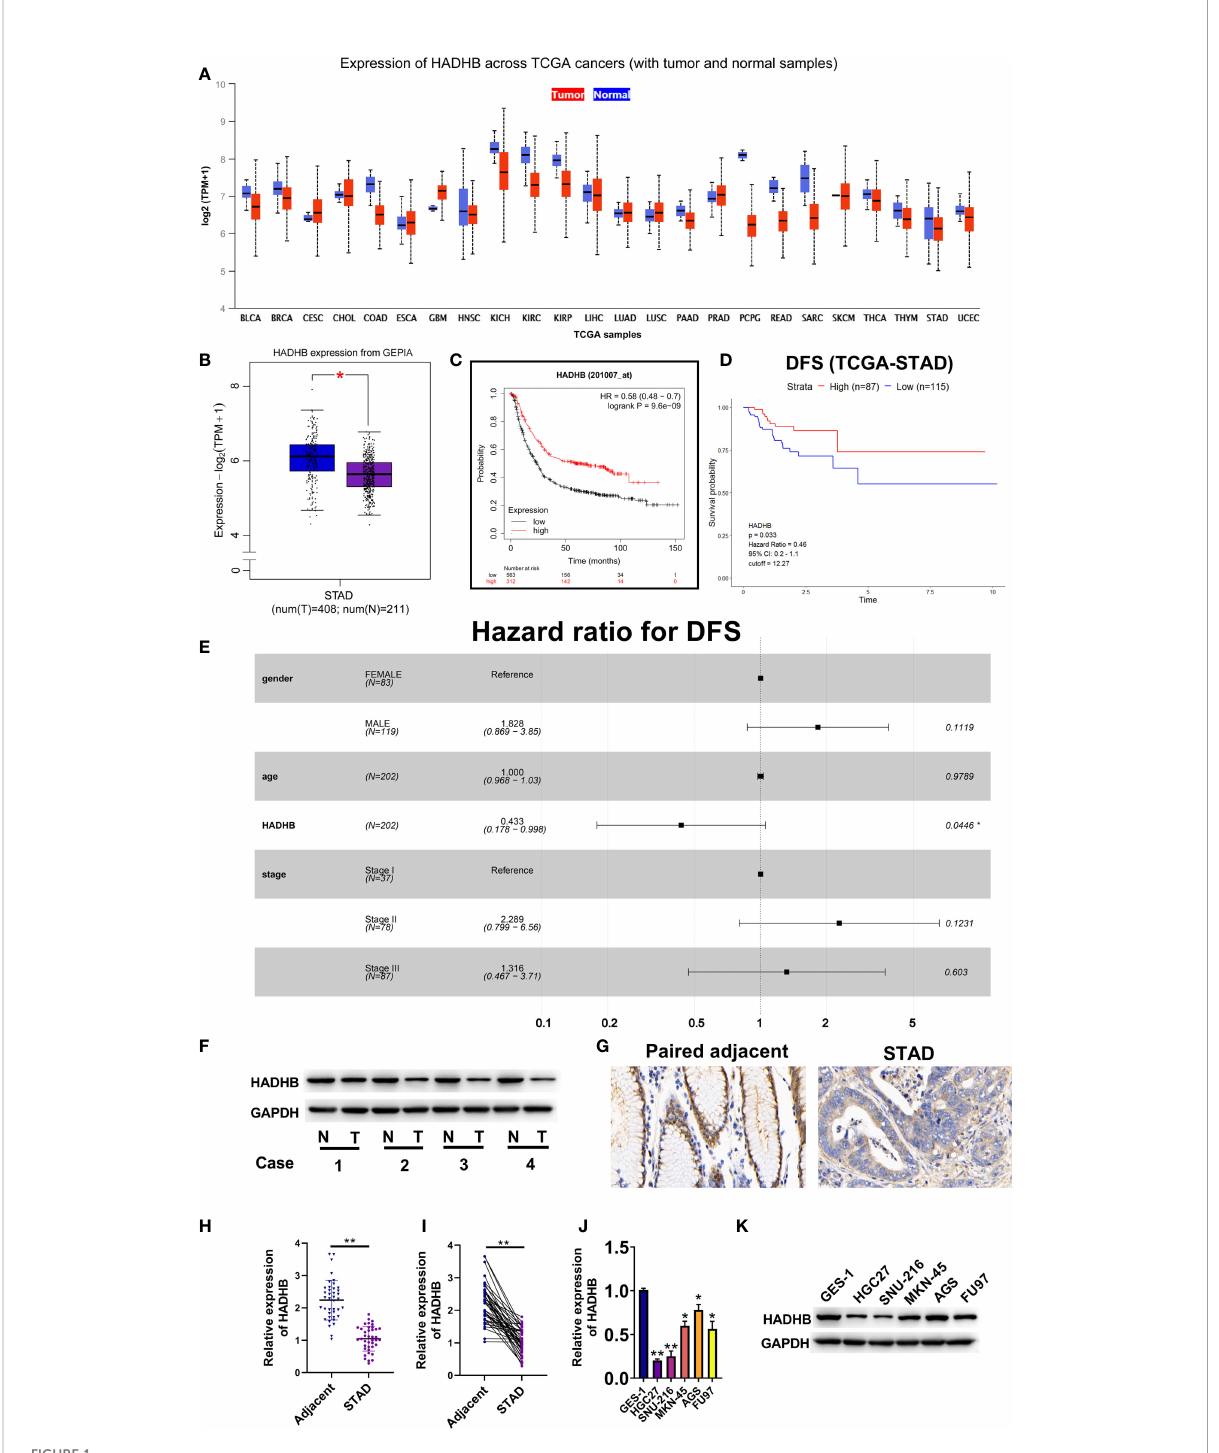
FIGURE 1 The expression of HADHB was low in STAD tissues and cell lines (A) . Differential mRNA expression of HADHB between normal tissues and tumour tissues in TCGA database. (B) . The mRNA expression of HADHB between normal tissues and tumour tissues in GEPIA. (C) . The relationship between the HADHB gene and overall survival (cutoff = 12.19) of STAD patients using Kaplan-Meier Plotter webtool. (D) . The relationship between the HADHB gene and disease-free survival (cutoff = 12.27) of TCGA-STAD patients using R software. (E) . Cox risk multivariable analysis of STAD. (F) . HADHB expression was determined using 4 pairs of signi fi cantly different clinical samples via western blot. (G) . HADHB expression was assessed via immunohistochemistry. (H, I) . HADHB expression in 40 pairs of clinical STAD tissues was determined using qRT-PCR. (J, K) . HADHB expression in STAD cell lines was determined using qRT-PCR and western blot. * P < 0.05, ** P <